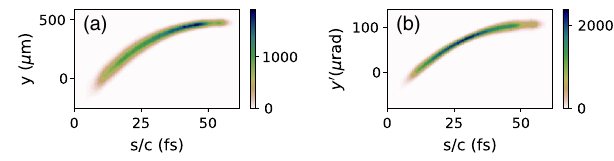
FIG. 14. With the single-dechirper setup d y ¼ 310 μ m, (a) the y − t distribution and (b) the y 0 − t distribution of the bunch at the undulator entrance. Notice that the tail of the beam is on the straight trajectory, since the lasing slice control for the first undulator section has been done.